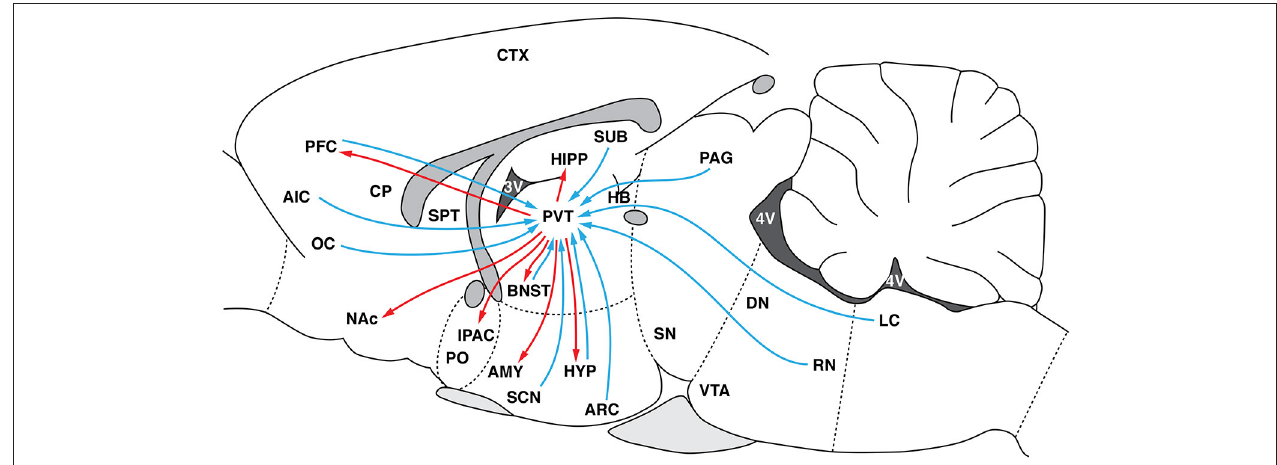
FIGURE 1 | Schematic representation of major PVT efferents (red arrows) and afferents (blue arrows). HYP, hypothalamus; PVT, paraventricular nucleus of the thalamus; ARC, arcuate nucleus of the hypothalamus; LC, locus coeruleus; RN, raphe nucleus; PN, parabrachial nucleus; CTX, cortex; PFC, prefrontal cortex; AIC, agranular insular cortex; OC, orbital cortex; CP, caudate-putamen; SPT, septum; AMY, amygdala; PAG, periaqueductal gray; BNST, bed nucleus of the stria terminalis; NAc, nucleus accumbens; IPAC, interstitial nucleus of the posterior limb of the anterior commissure; PO, preoptic area; HIPP, hippocampus; SUB, subiculum; SN, substantia nigra; VTA, ventral tegmental area, SCN, suprachiasmatic